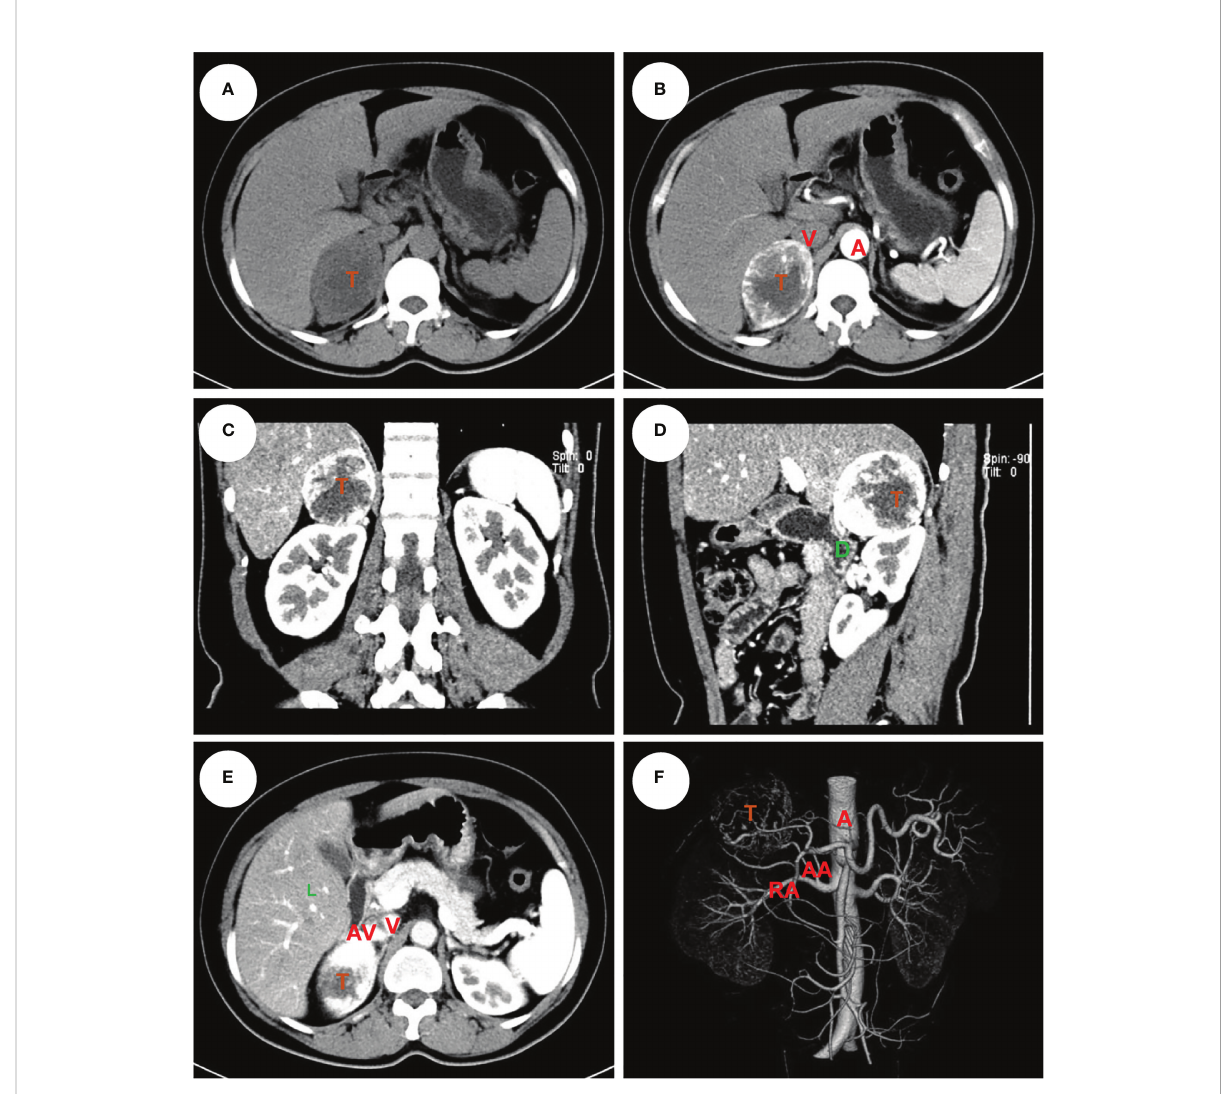
FIGURE 2 An example of right pheochromocytoma. The female patient had a 6 cm pheochromocytoma arising from the right adrenal gland (A) with 120 HU on contrast-enhanced CT (B) . A clear tumor boundary was observed on transverse (B) , coronal (C) and sagittal (D) section which revealed a close relationship between the tumor and ipsilateral kidney, right hepatic lobe and duodenum. An arterial-venous phase section (E) showed a short adrenal vein draining directly into the vena cava. The 3-D vessel reconstruction based on arterial phase CT scan demonstrated the relative location of the tumor to surrounding major abdominal vessels (F) . The tumor was removed robotically via retroperitoneal approach. The patients had an ADRENAL score of 2 A + 1 D + 0 R + 2 E + 1 N + 1 A + R L = 7R. T, tumor; L, liver; D, duodenum; A, aorta; V, (inferior) vena cava; RA, renal artery; AA, (middle) adrenal artery; AV, adrenal